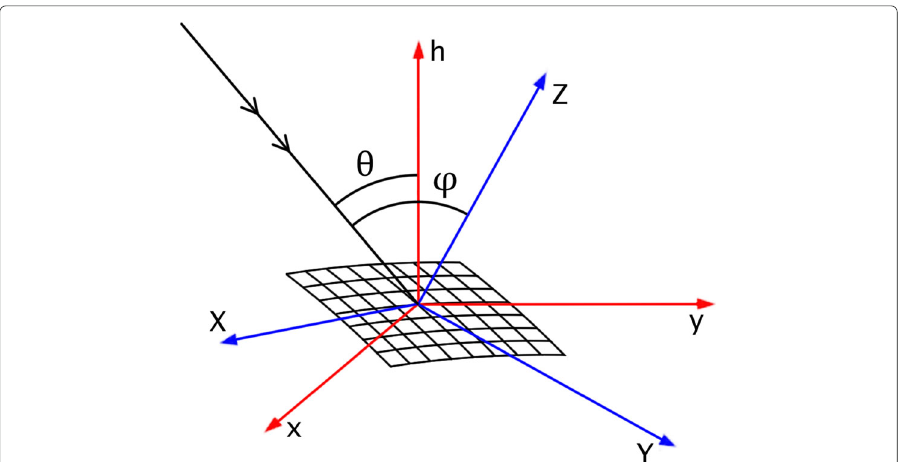
Fig. 1 Illustration of the local reference frame ( X , Y , Z ) relative to the laboratory frame ( x , y , h ) . θ is the angle between the h -axis and the ion trajectory, and ϕ is the angle between the local normal, Z , and the ion